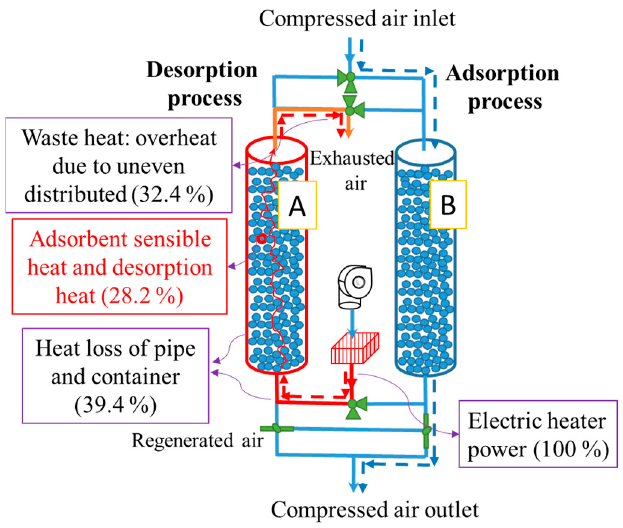
Figure 1. Energy analysis of heated-air-flow compressed air dryer.